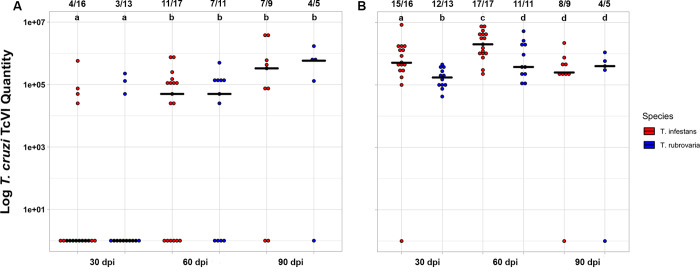
T. cruzi TcVI metacyclic trypomastigote (A) and epimastigote (B) loads in the excreta of T. rubrovaria and T. infestans. The number of infected and the total number of specimens analyzed for each condition are shown above each dotplot column. Different lowercase letters on the top indicate statistically significant differences (Kruskal-Wallis-test; A: p (a and b) < 0.05; Wilcoxon-Mann-Whitney W-tests B: p (a and b) = 0.002 and p (c and d) = 0.02). dpi = days post infection.